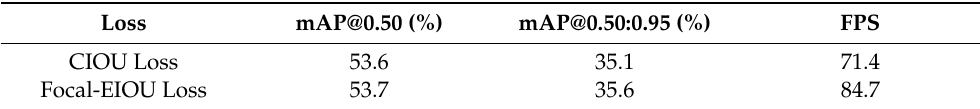
Table 3. Performance comparison of the original and improved algorithms.